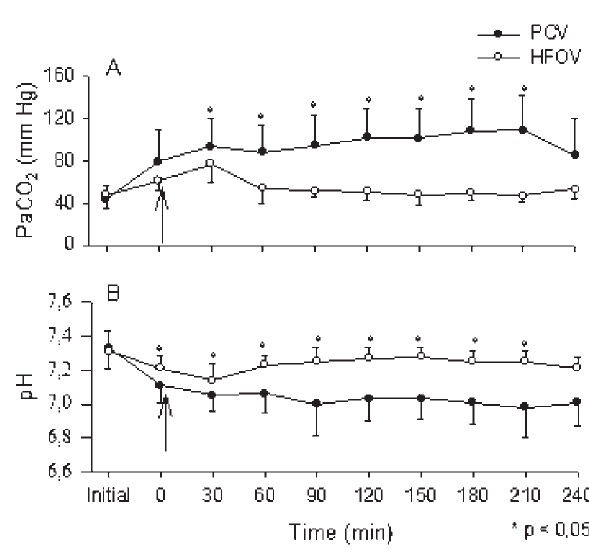
. Due to the 2 values were higher 2